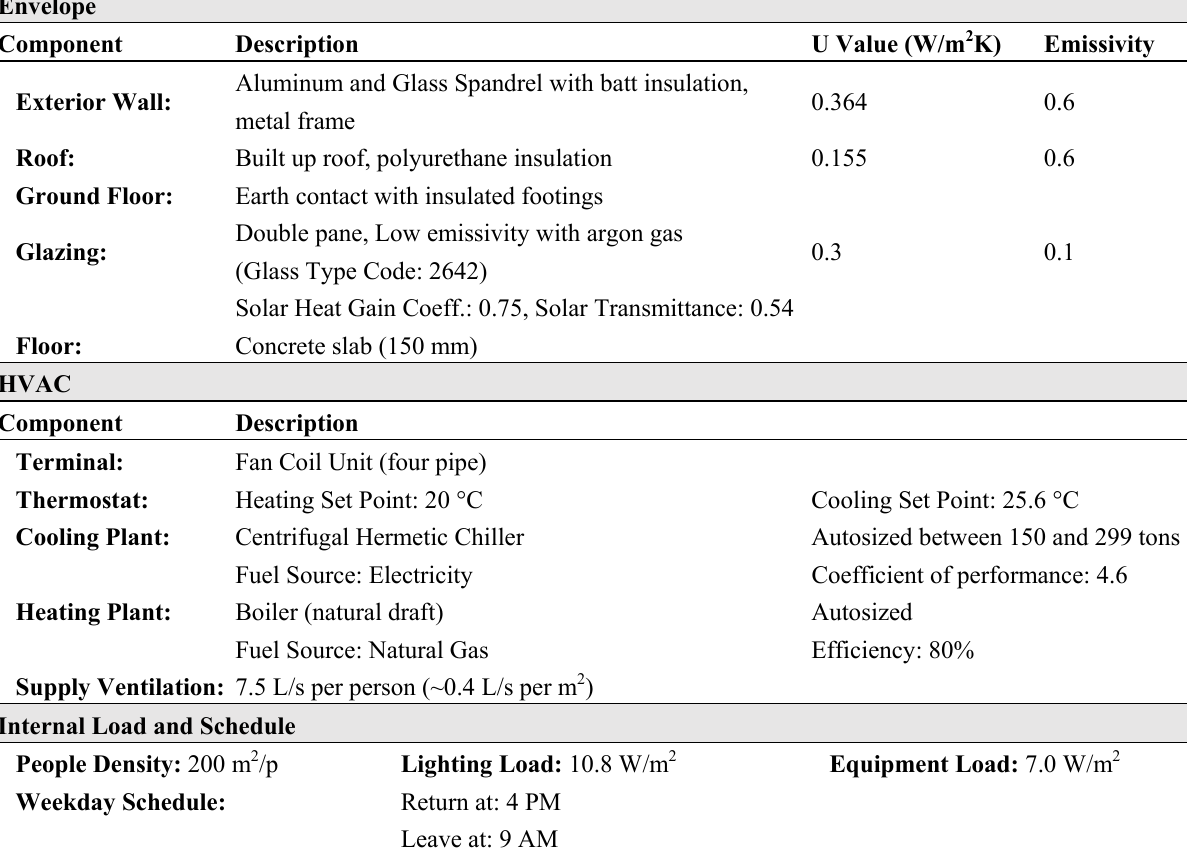
Table 2. Model simulation parameters.